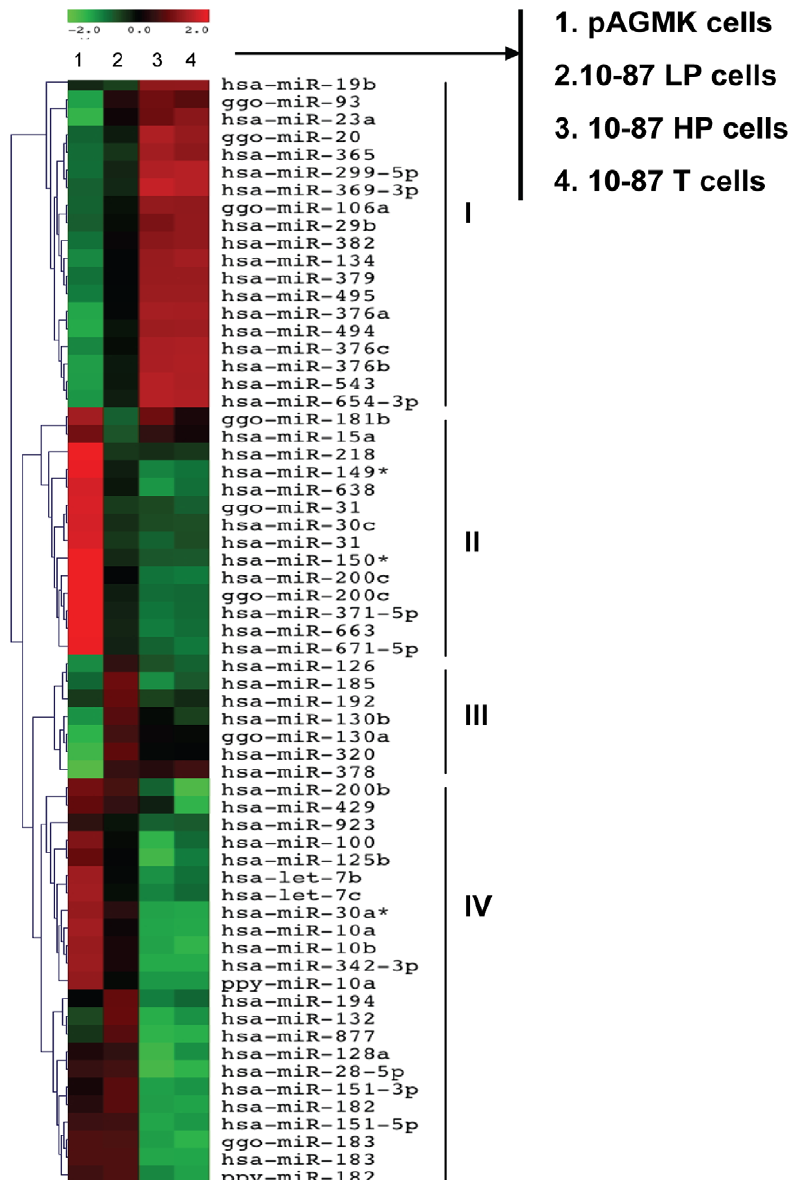
Figure 3. Hierarchical clustering of miRNA expression. miRNAs included in the heat-map had a fold change . 6 2 and were significantly expressed ( p , 0.01). Each row shows the relative expression level for a single miRNA and each column represents miRNA profiles of the average triplicate array data: (1) pAGMK cells; (2) 10-87 LP cells; (3) 10-87 HP cells; (4) 10-87 T cells. The red or green color indicates relative high or low expression, respectively. Expression clusters representing different patterns of up-regulation to down-regulation are depicted by Roman numerals on the right hand side of the Figure.